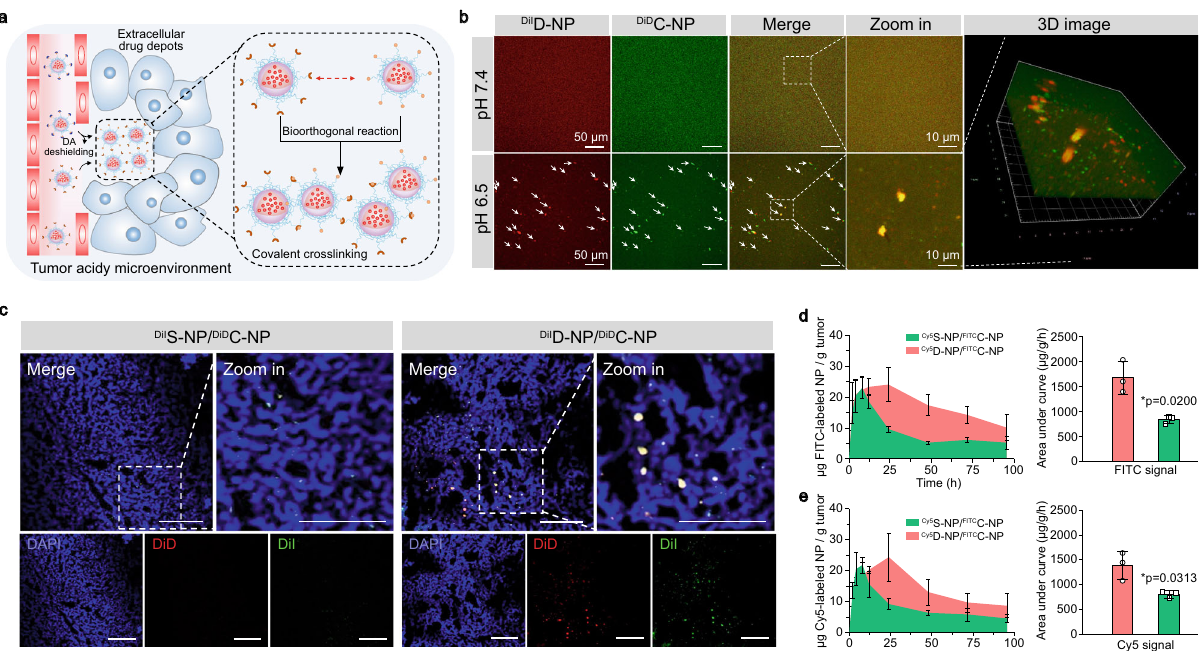
Fig. 5 Intratumoral in situ assembly of D-NP/C-NP constructs drug depots to deliver multiple agents into the tumor site simultaneously. a Schematic illustrating the bioorthogonal in situ assembly of D-NP/C-NP in the tumor area for the simultaneous delivery of multiple agents. b 3D CLSM images of the D- NP/C-NP aqueous solutions at pH 7.4 and 6.5 after incubation for 2h. D-NP and C-NP were labeled with DiI and DiD, respectively. Experiments were repeated twice. c In vitro fl uorescence imaging of frozen tumor sections after 96 h administration of D-NP/C-NP or S-NP/C-NP. C-NP was labeled with DiD, and D-NP and S-NP were labeled with DiI. Scale bar, 100 µ m. Experiments were repeated twice. d , e Time-dependent tumor accumulation (left) of d FITC-labeled and e Cy5-labeled NPs after administration of D-NP/C-NP or S-NP/C-NP. C-NP was labeled with FITC, and D-NP and S-NP were labeled with Cy5. The area under the curve (AUC) (right) of the labeled NPs in tumor tissues. Data are presented as the mean±s.d. ( n = 3). Statistical signi fi cance was calculated via Student ’ s t - test (one tail) in d , e . * p <0.05. DA: 2, 3-dimethylmaleic anhydride, DiI: 1,1'-Dioctadecyl-3,3,3',3'-tetramethylindocarbocyanine perchlorate, DiD: 1,1-Dioctadecyl- 3,3,3,3-tetramethylindodicarbocyanine. Source data are provided as a Source Data fi